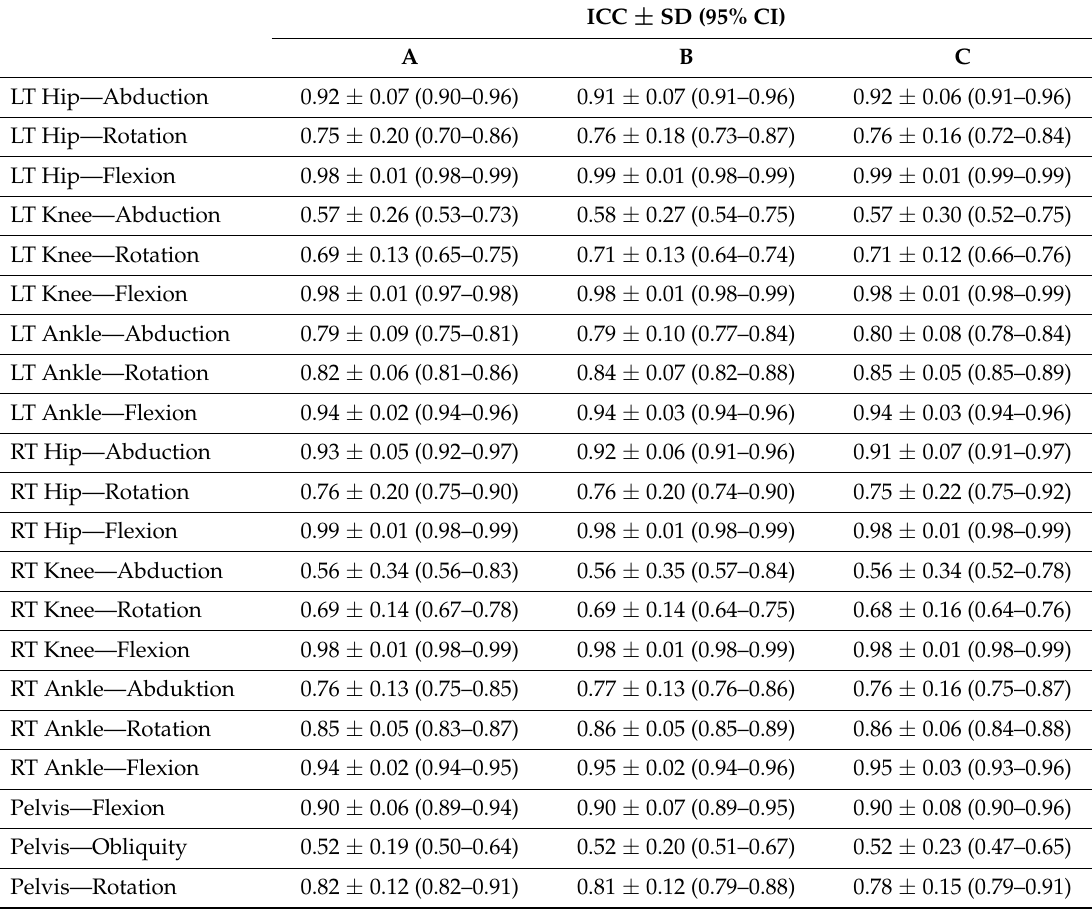
Table 4. Mean intraclass correlation coefficient (ICC) values for the IMU system over all subjects ± SD; brackets contain 95% CI. A, B, C indicate beginning, middle, and end of the 6 min walk